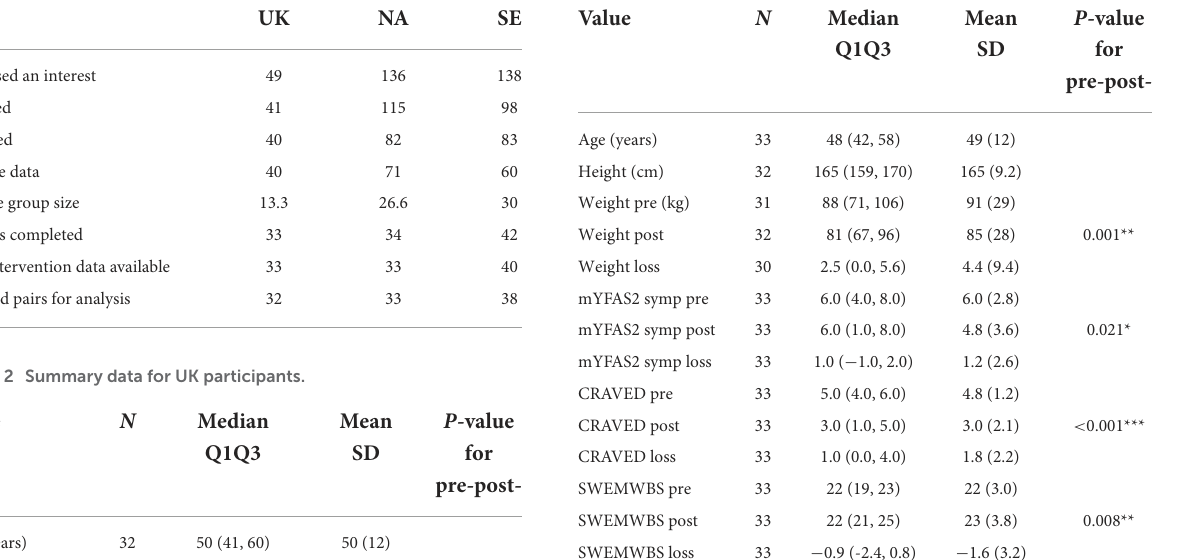
TABLE 3 Summary data for NA participants.